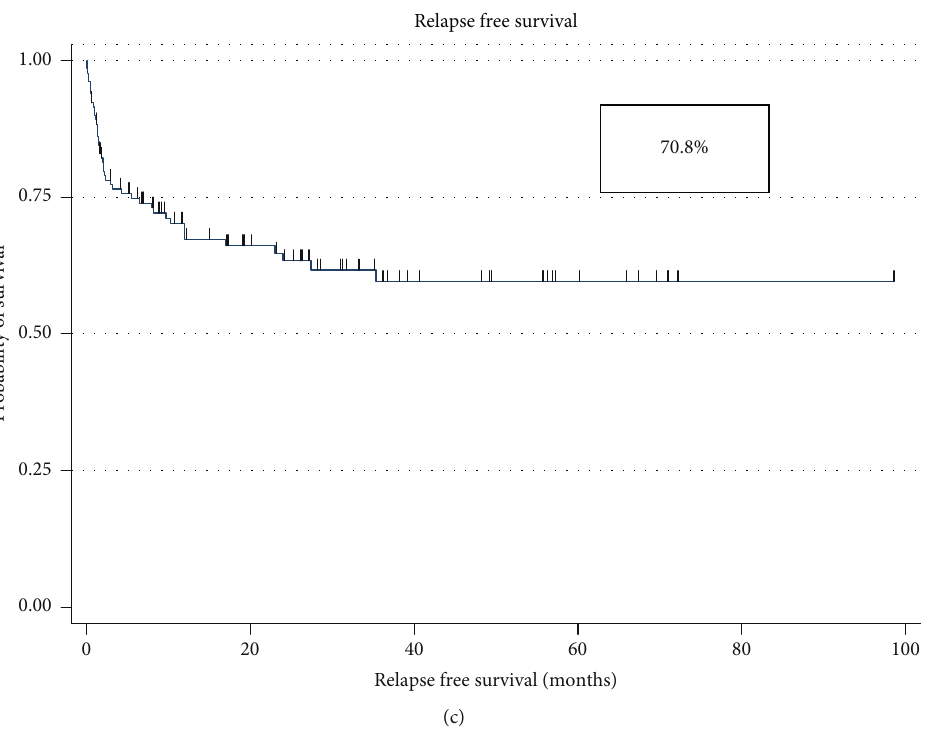
Figure 1: Overall survival (OS), GvHD-free survival (GFS), and relapse-free survival (RFS) in acquired aplastic anemia patients: (a) OS was 73.8%, (b) GFS was 63.1%, and (c) RFS was